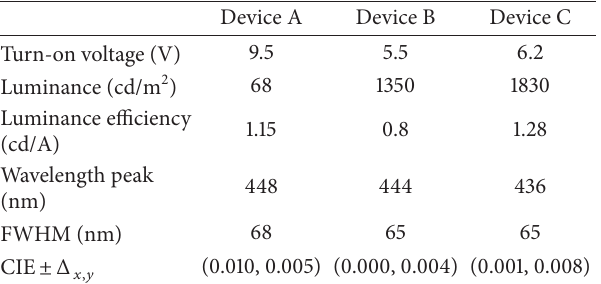
Table 1: Performance of devices A–C. Device A Device B Device C